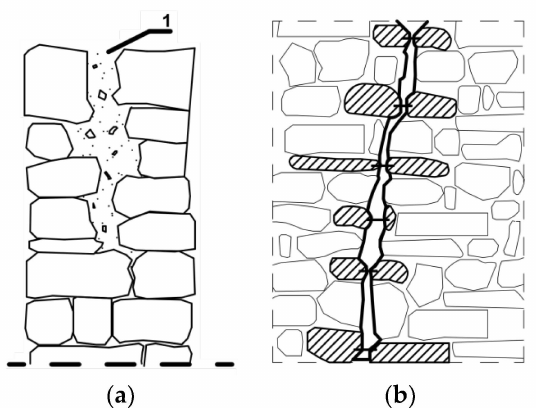
Figure 16. Technical details: ( a ) Stone wall with points of mortar injections. ( b ) Clamps or fittings perpendicular to the cracks in the wall (Drawings: Lejla